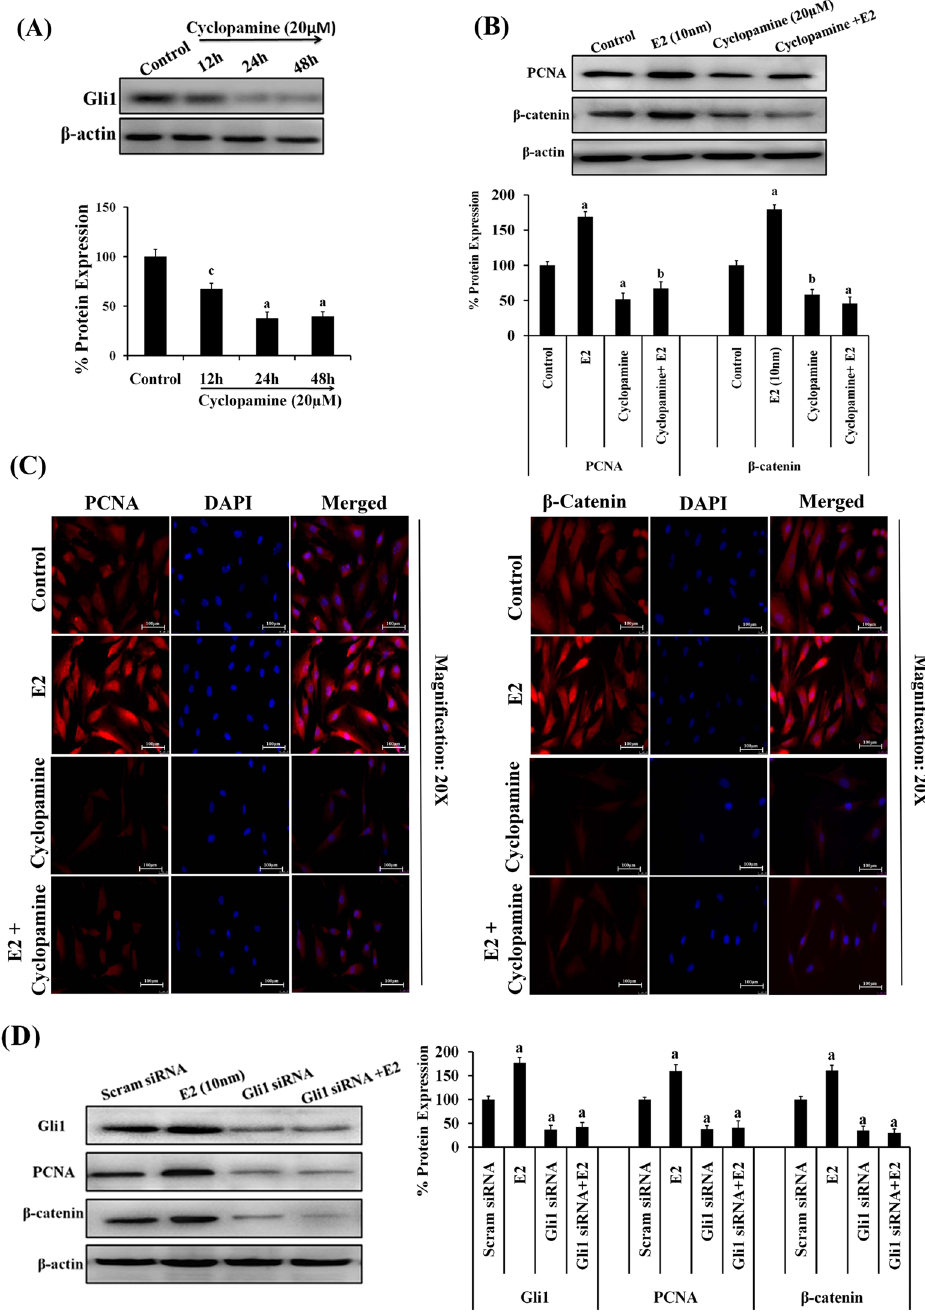
Figure 4. Effect of cyclopamine, Hh signaling inhibitor or knockdown of Gli1 on growth inhibition of endometrial hyperplasial cells. ( A ) Representative western blots showing a decline in Gli1 expression in time- dependent manner (12 h, 24 h, 48 h) in EH cells treated with cyclopamine. β -actin was used as internal loading control. Densitometric data shown as % change in protein expression levels. Values are expressed as mean ± SEM, n = 3 (independent samples). p values: a p < 0.001, c p < 0.05 vs control. ( B ) Representative western blot images illustrating the effect of cyclopamine on proliferative markers (PCNA and β -catenin) in primary EH cells. EH cells were treated with vehicle or E2 or cyclopamine alone or alongwith E2 for 24 h. Densitometric data shown as % change in protein expression levels. Values are expressed as mean ± SEM, n = 3 (independent samples). p values are: a p < 0.001, b p < 0.01, vs. control. ( C ) Immunofluorescence images demonstrating the distribution of PCNA or β -catenin in EH cells pre-treated with cyclopamine in presence and absence of estrogen for 24 h. Experiments were repeated at least three times. ( D ) Representative western blots images depicting the effect of Gli1 silencing on expression of proliferative markers as PCNA or β -catenin. β -actin was used as internal loading control. Densitometric data shown as % change in protein expression levels. Values are expressed as mean ± SEM, n = 3 (independent samples). p values: a p < 0.001 vs.